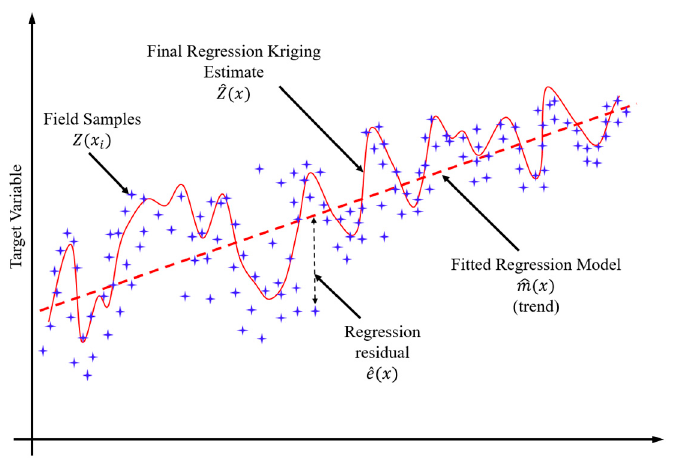
Figure 2. Graphical example of regression kriging.